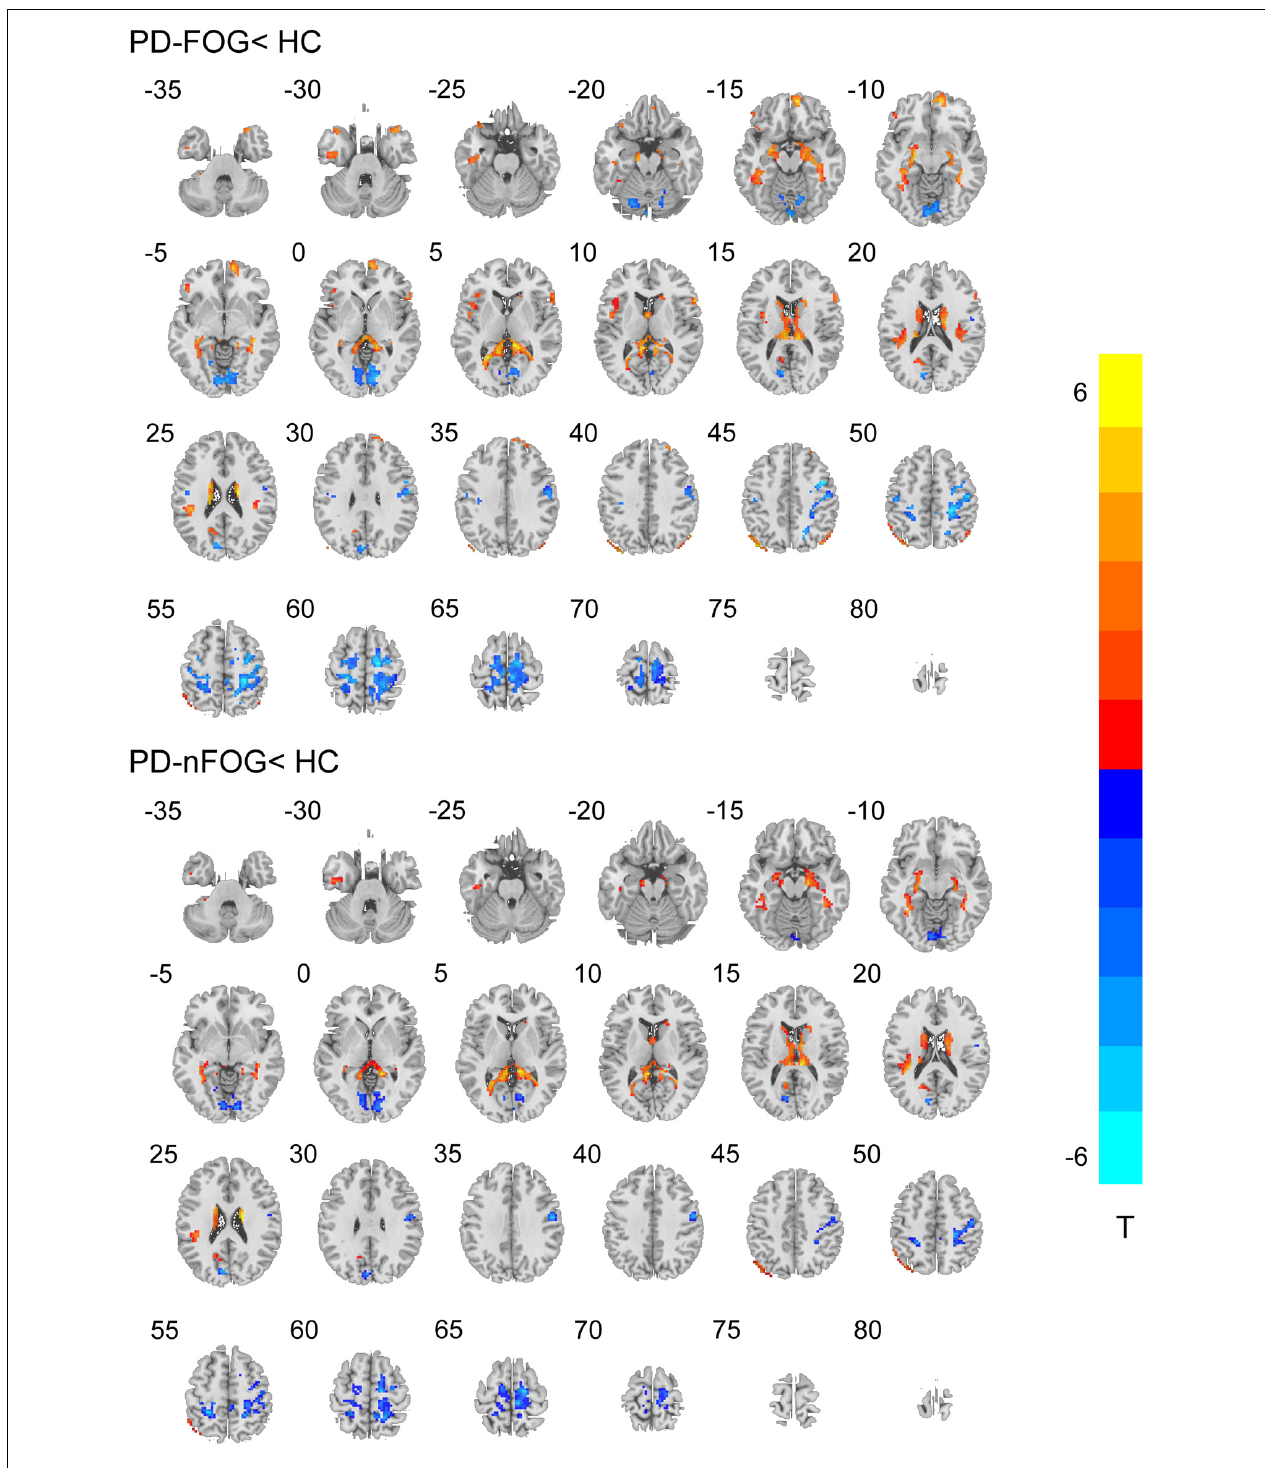
FIGURE 1 | Degree centrality (DC) result maps of the comparison between patients and healthy control (HC) groups on axial images ( p < 0.001, AlphaSim corrected). The left side of the image corresponds to the left side of the brain in axial orientation. Slice coordinates according to the Montreal Neurological Institute (MNI) space are shown on the upper left corner of the slices, indicating the Z -axis in axial orientation. The t -value scale is seen to the right of the image.